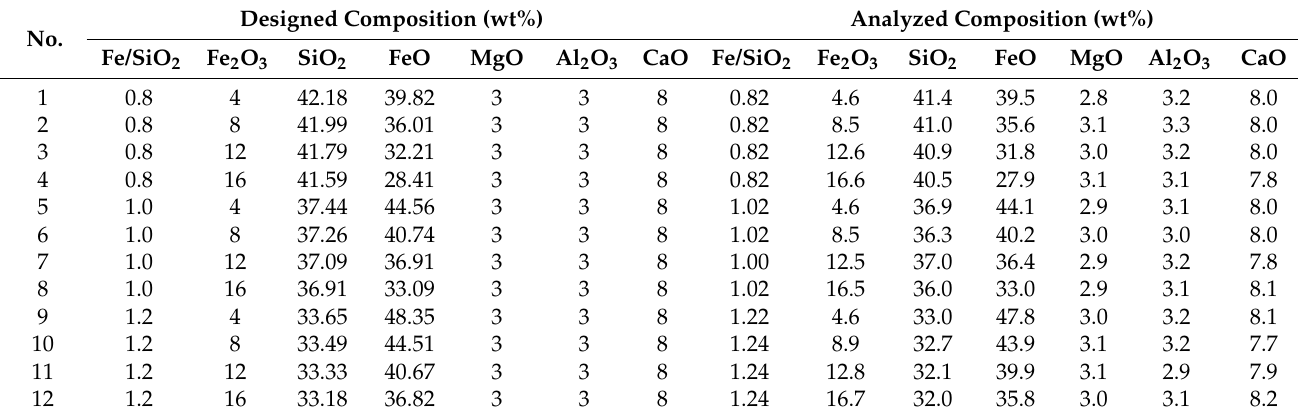
Table 1. Chemical compositions of samples in viscosity determination experiments (wt%).